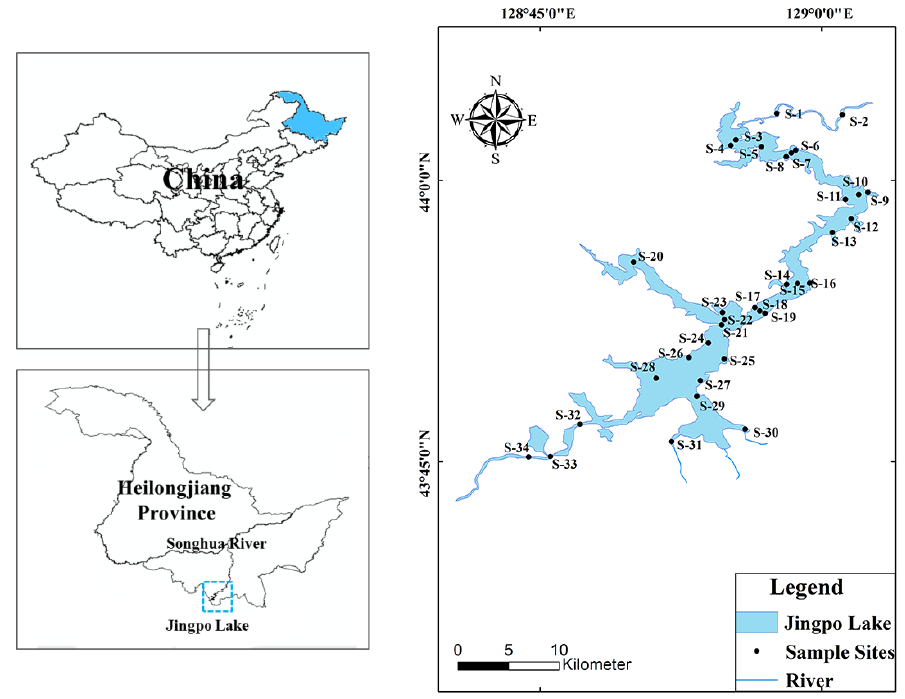
Figure 1. The location of sampling sites in the study area.